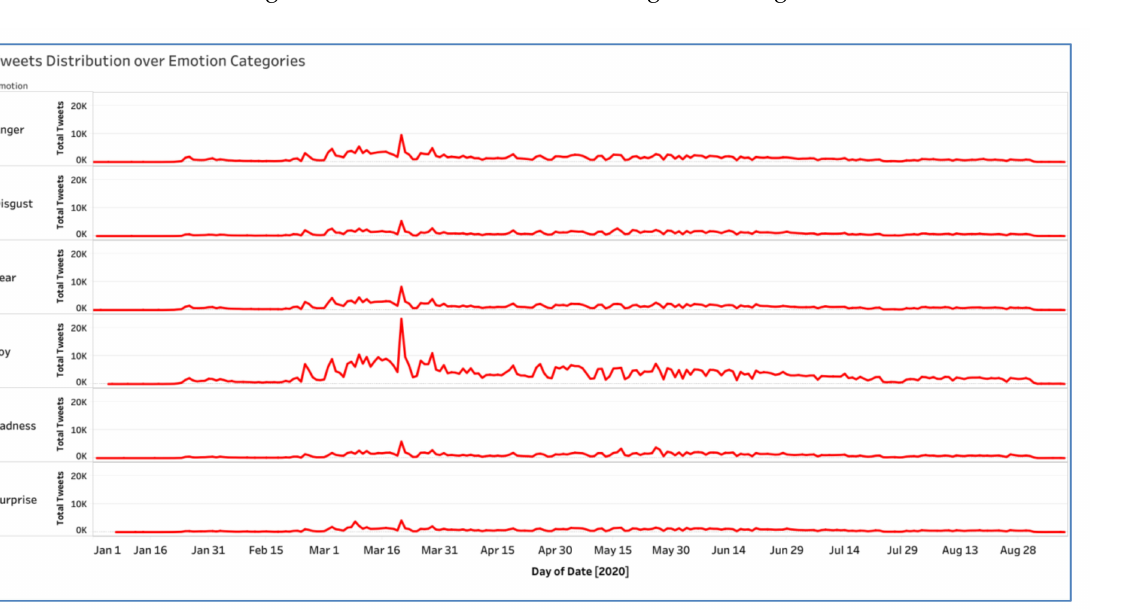
Figure 7. Emotion